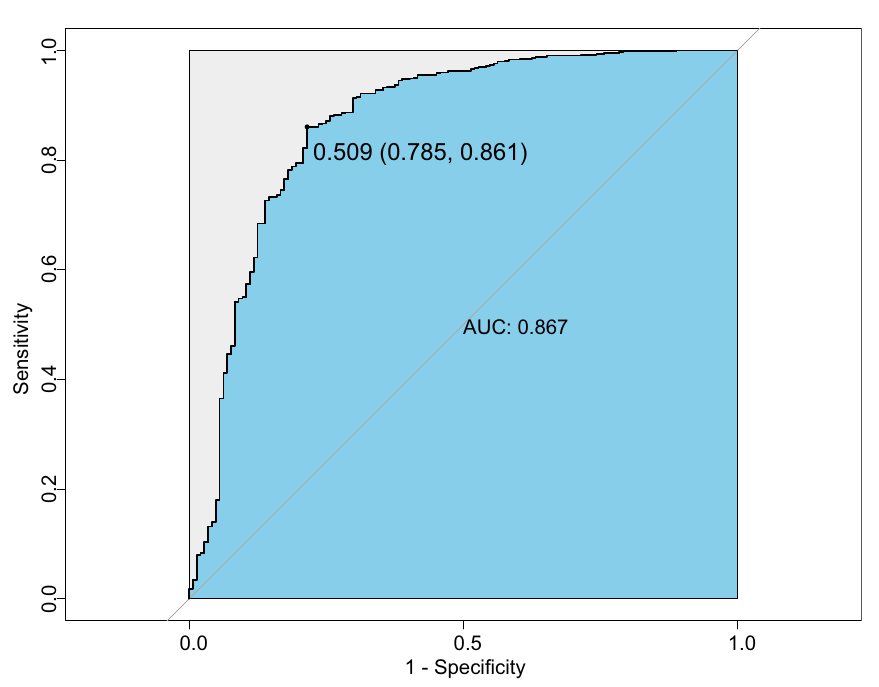
Figure 6. ROC curve showing discrimination effective of nomogram used in all MN and